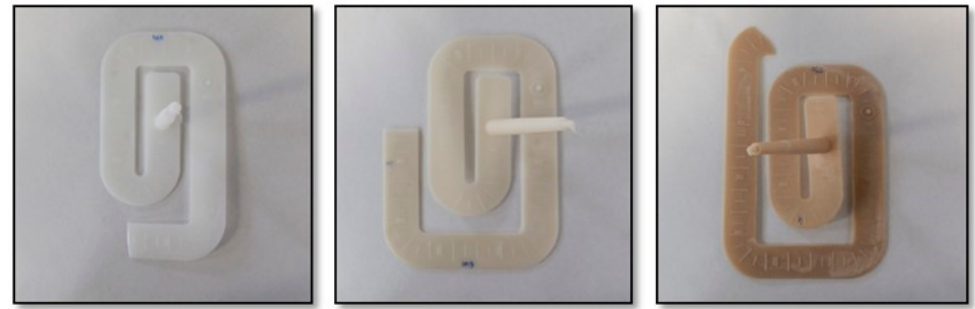
11 of 19 Figure 7. Apparent viscosity of the samples by capillary rheometry versus shear rate: (left) 240 °C and (right) 260 °C. It is known that the shear behavior in the melt of star-shaped macromolecules differs